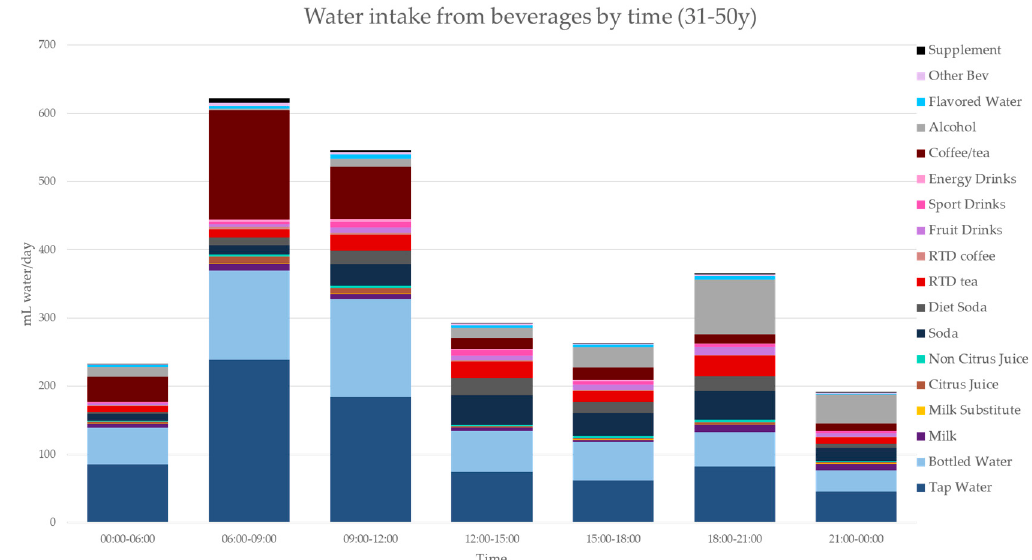
Figure 6. Water intakes (mL/d) by beverage type and time of day for the 19–30 y age group (NHANES 2011–2016).